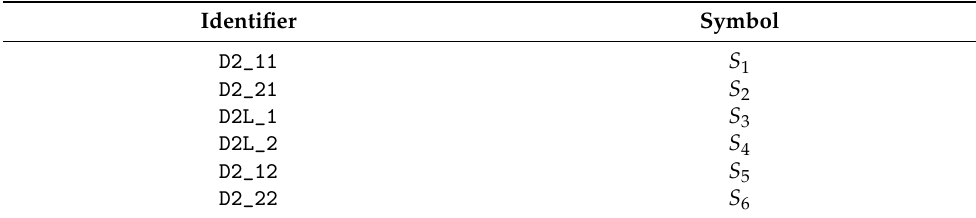
Table 2. Traffic intensity sensors.